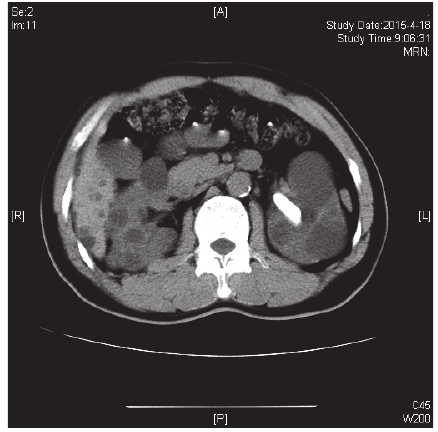
Figure 1: CT scan: left renal calculus with multiple cysts.